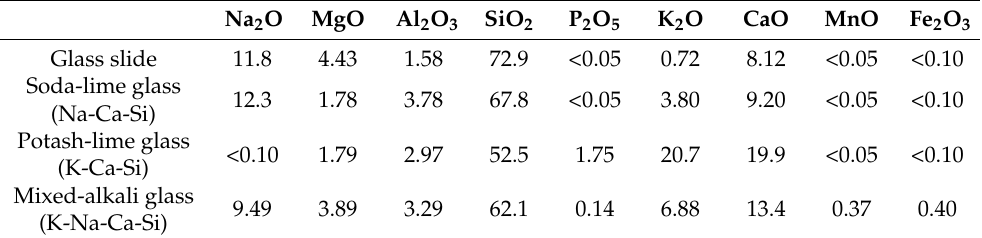
Table 3. Substrate glasses composition (wt.%) obtained by XRF.